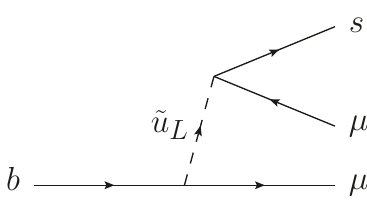
Figure 1 . Tree level decay for b ! s(cid:22)(cid:22) involving two (cid:21) 0